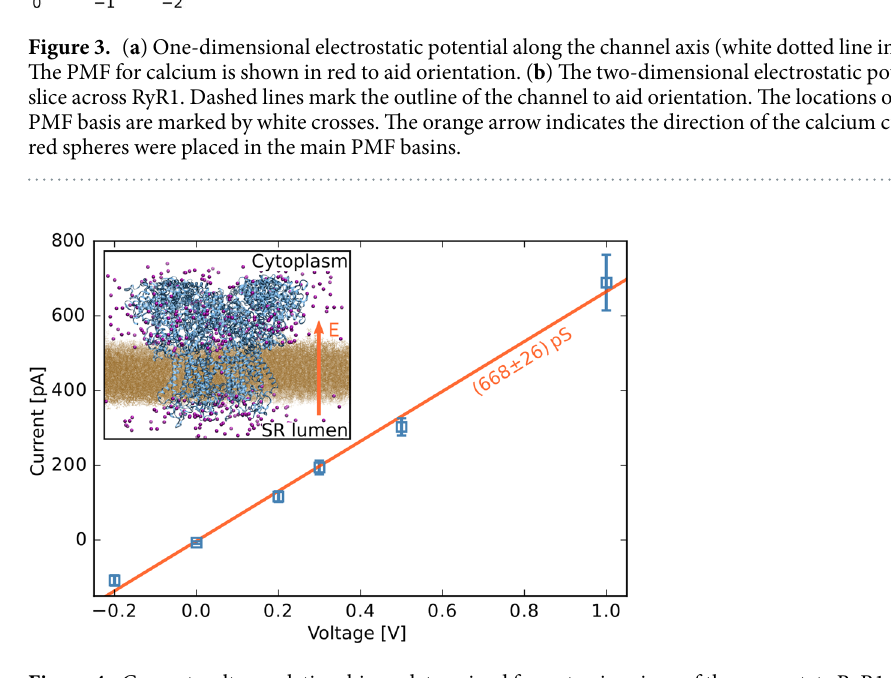
Figure 4. Current-voltage relationship as determined for potassium ions of the open-state RyR1. A linear fit to all data points from − 0.2 to 1.0 V reveals a conductance of (668 ± 26) pS at 140 mmol/L. The inset shows a rendering of the simulated system; the arrow symbolizes the direction of the electric field added to the simulation and thus also indicates the direction of